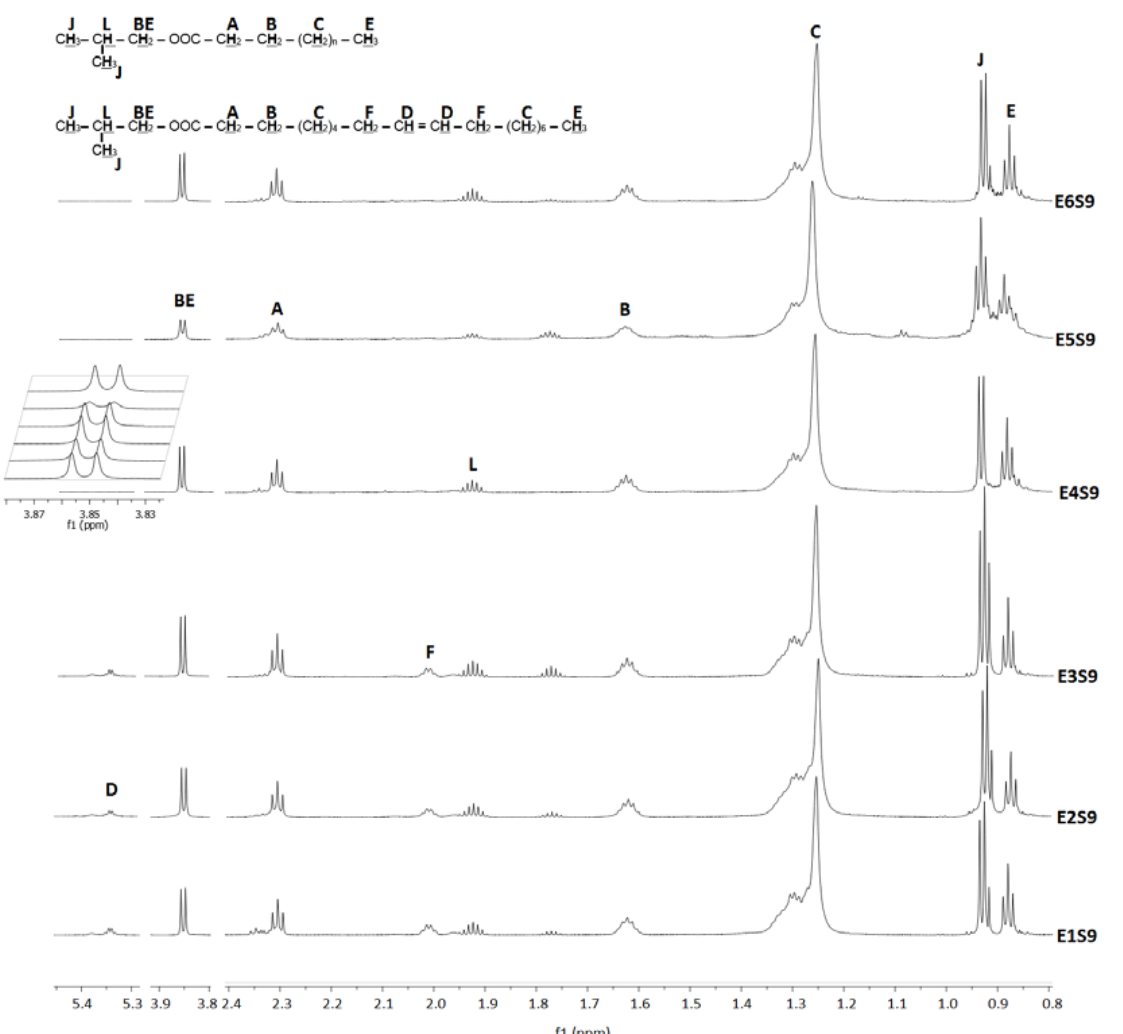
Figure 2. 1 H-NMR spectra for FABE obtained from beef tallow by using supercritical iso-butanol.